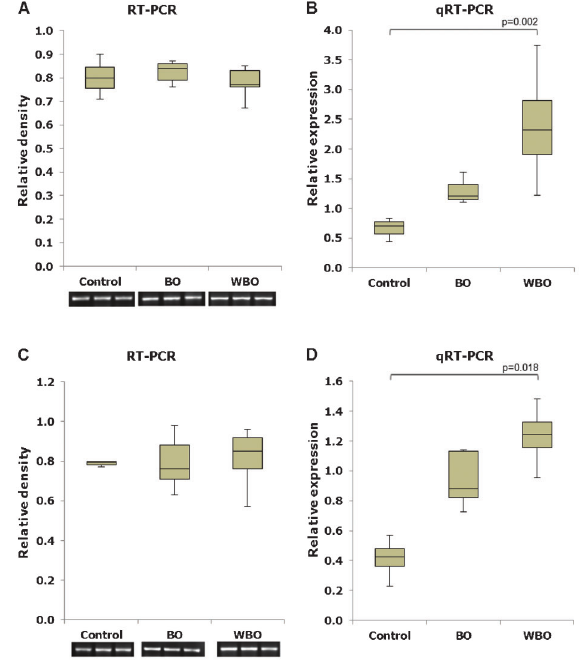
Figure 2. Gene expression profile of desmin from control rats, BO and WBO parenchymas. A , C , Semiquantitative analysis (RT- PCR) of the relative density at 7 days ( A ) and 60 days ( C ) after selective ligation of the bile duct. B , D , Quantitative analysis (qRT-PCR) at 7 days ( B ) and 60 days ( D ) after selective ligation of the bile duct. The gene expression values were obtained by relative quantification using the 2 - DD ct method. BO: biliary obstruction; WBO: without biliary obstruction. One-way ANOVA was used for the statistical